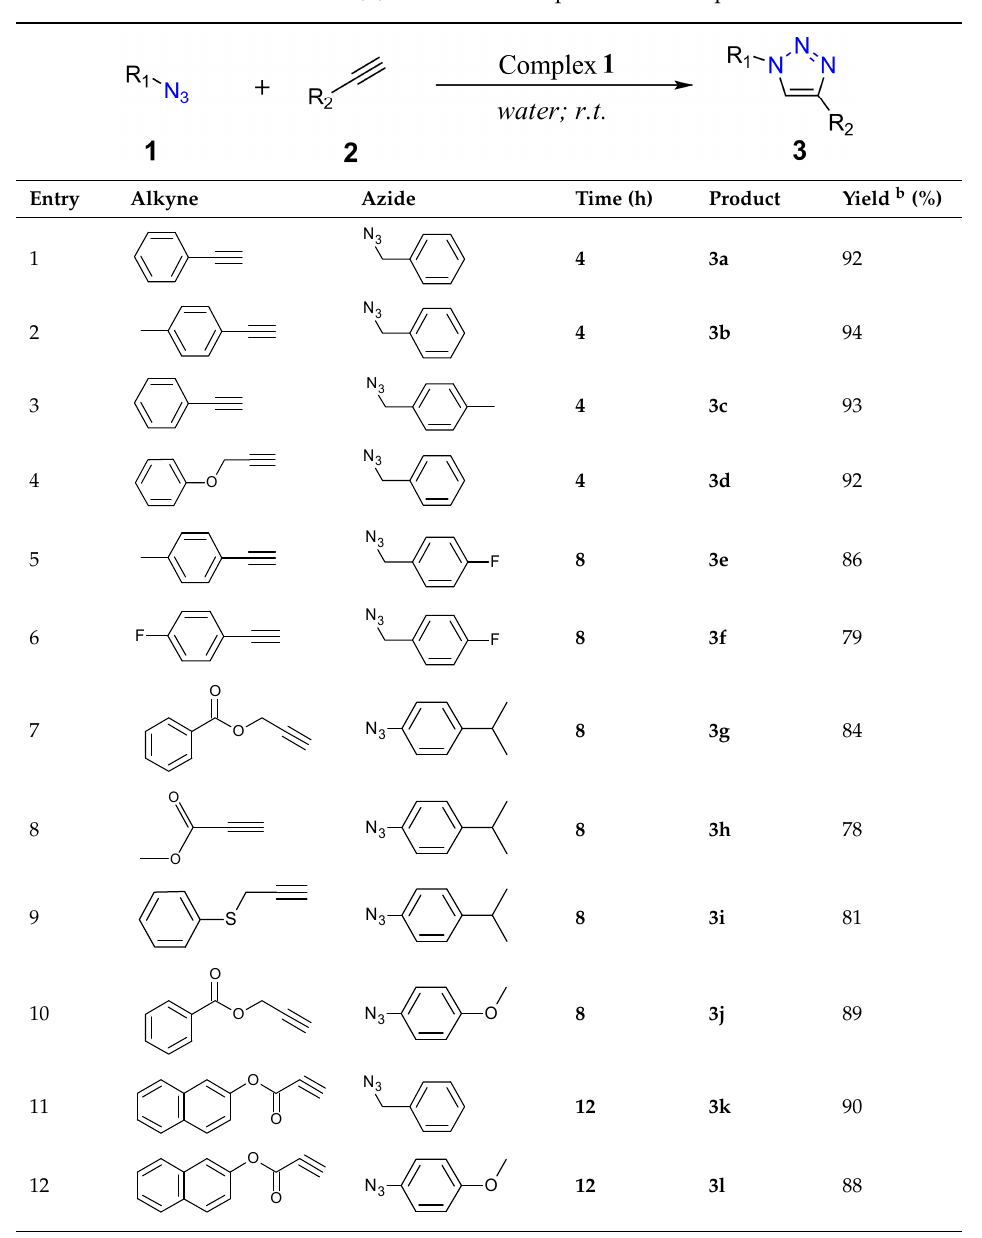
Table 3. Click of 1,2,3-triazoles in the presence of complex 1 a .